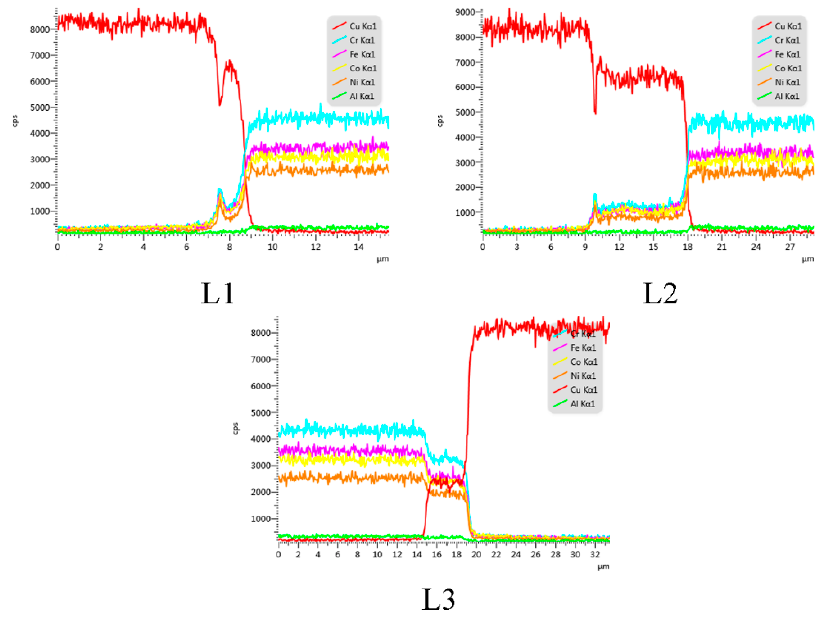
Figure 10. The distribution of the elements on the line L1, L2, and L3 in Figure 7.